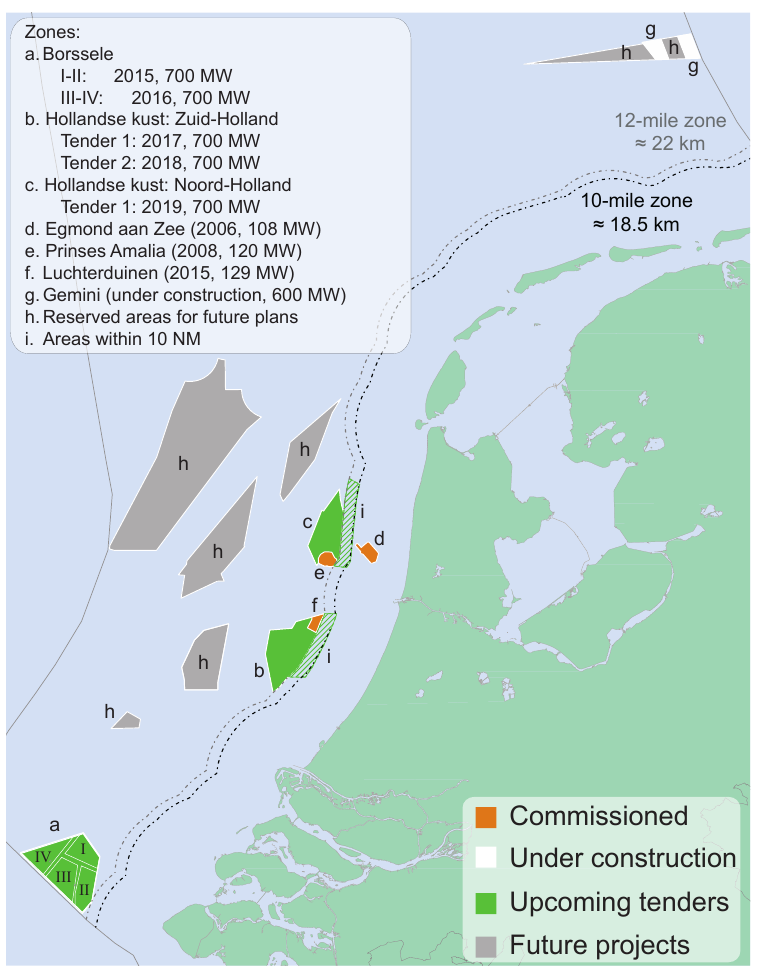
Figure 11. Dutch commissioned, under construction, planned and future OWF areas [81,82].